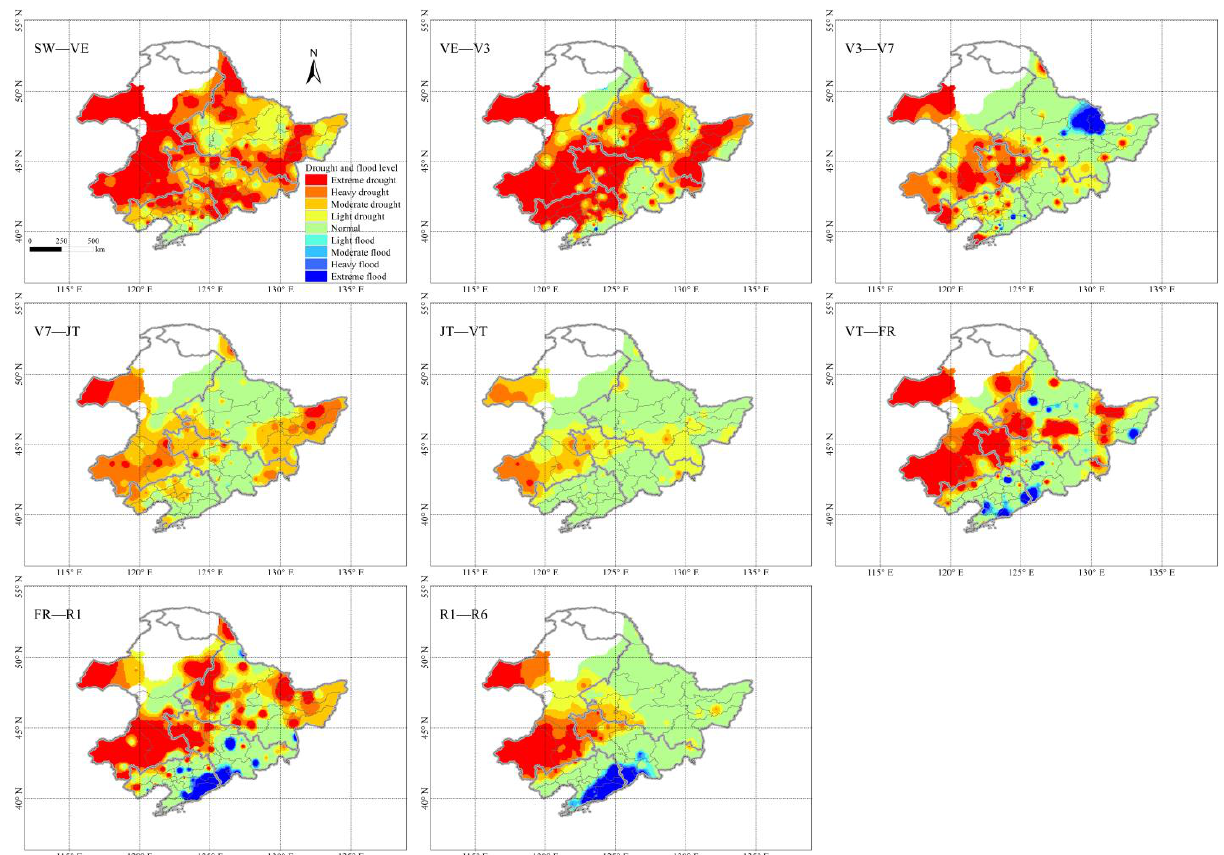
Figure 5. Spatial distribution of drought and waterlogging levels in the maize growth stages in Northeast China. NOTE: SW: sowing stage; VE: emergence stage; V3: three-leaf stage; V7: seven-leaf stage; JT: jointing stage; VT: tasseling stage; FR: flowering stage; R1: silking stage; R6: harvesting stage.